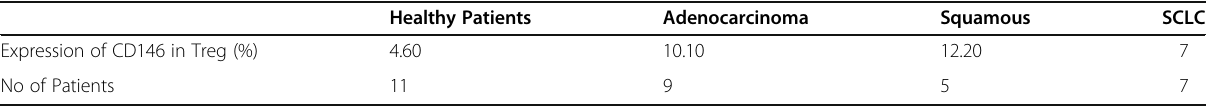
Table 1 Expression of CD146 on Treg in healthy and lung cancer patients showing number of patients Healthy Patients Adenocarcinoma Expression of CD146 in Treg (%) No of Patients